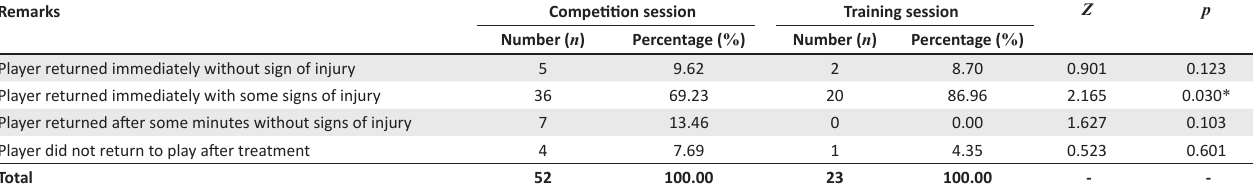
TABLE 4: Player’s level of recovery after injury during competition and training.